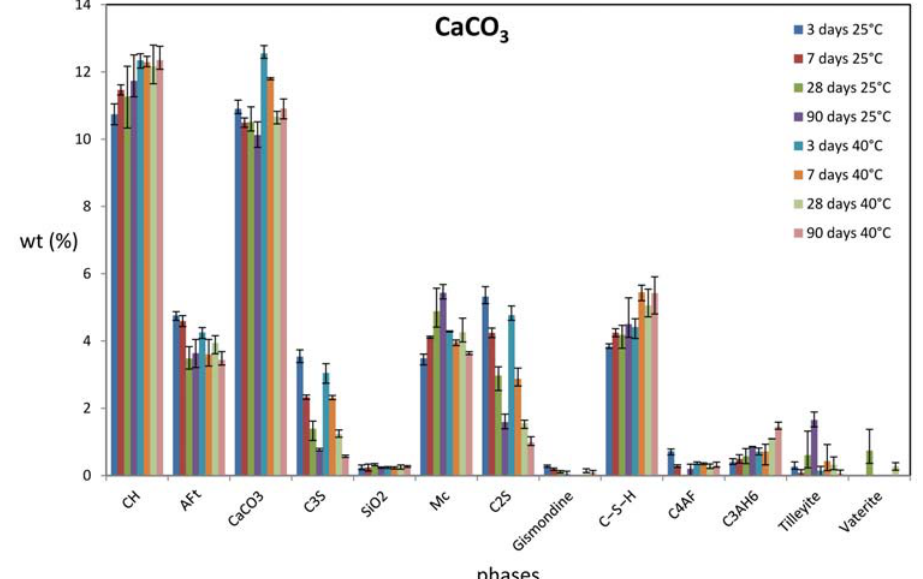
CC– at 3, 7, 28 and 90 days of hydration and two temperatures, 25